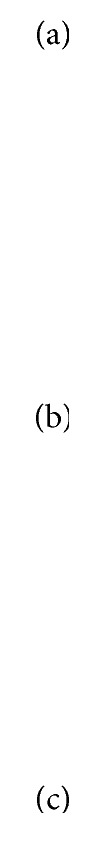
Contrast-enhanced MRI of the abdomen on initial staging of the renal tumor. (a) Coronal T1-weighted image and (b) axial T2-weighted image demonstrated a left renal mass in the upper pole of the left kidney with cystic areas (arrows).